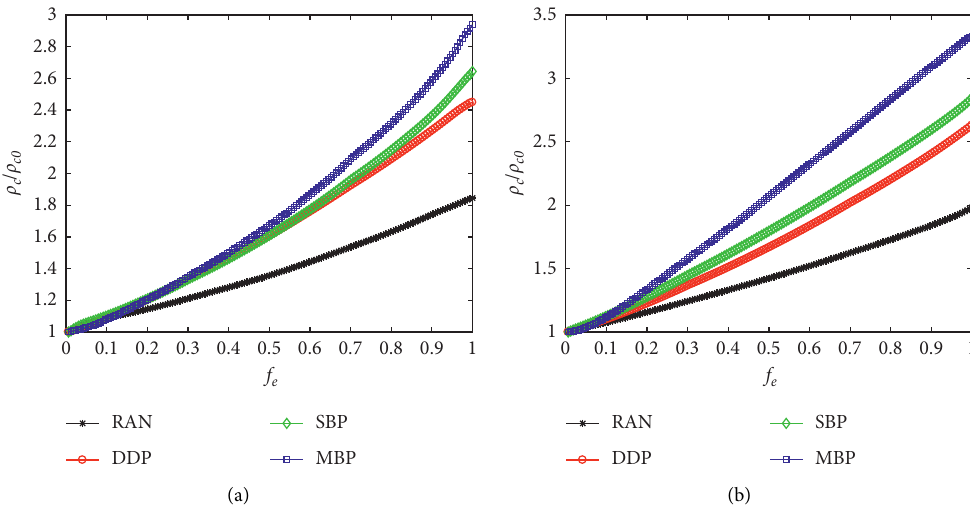
Figure 6: The enhancement of our strategies in a real multiplex network. (a) In “Work” network. (b) In “Lunch”